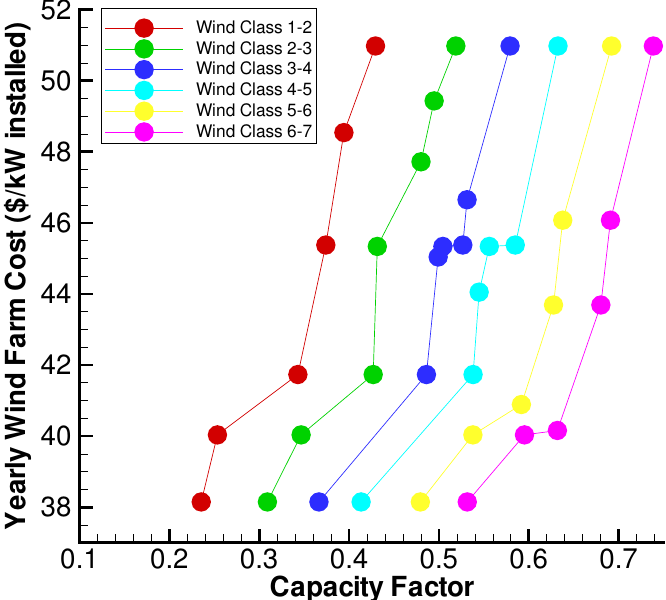
Figure 13. Best tradeoffs between wind farm capacity factor and average annual cost ($/kW installed) for different wind